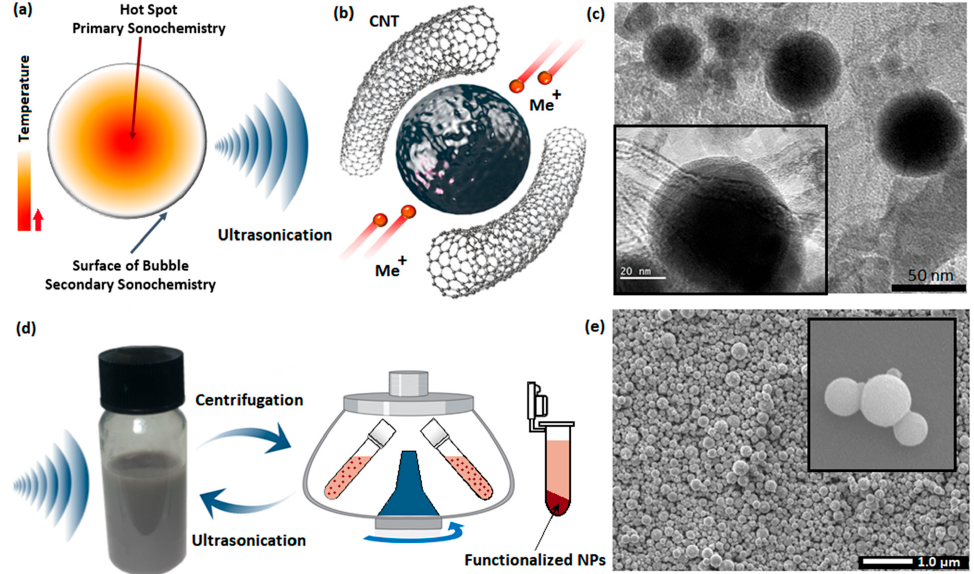
Figure 1. ( a ) The schematic representation of acoustic bubble and its corresponding hot-spot and surface regions where the primary and secondary sonochemistry reactions occur. ( b ) The graphical scheme of engulfed galinstan NP in CNT network and ( c ) its corresponding TEM image. ( d ) The sequential ultrasonication and centrifugation process for CNT removal. ( e ) The SEM image of func- tionalized galinstan NPs.